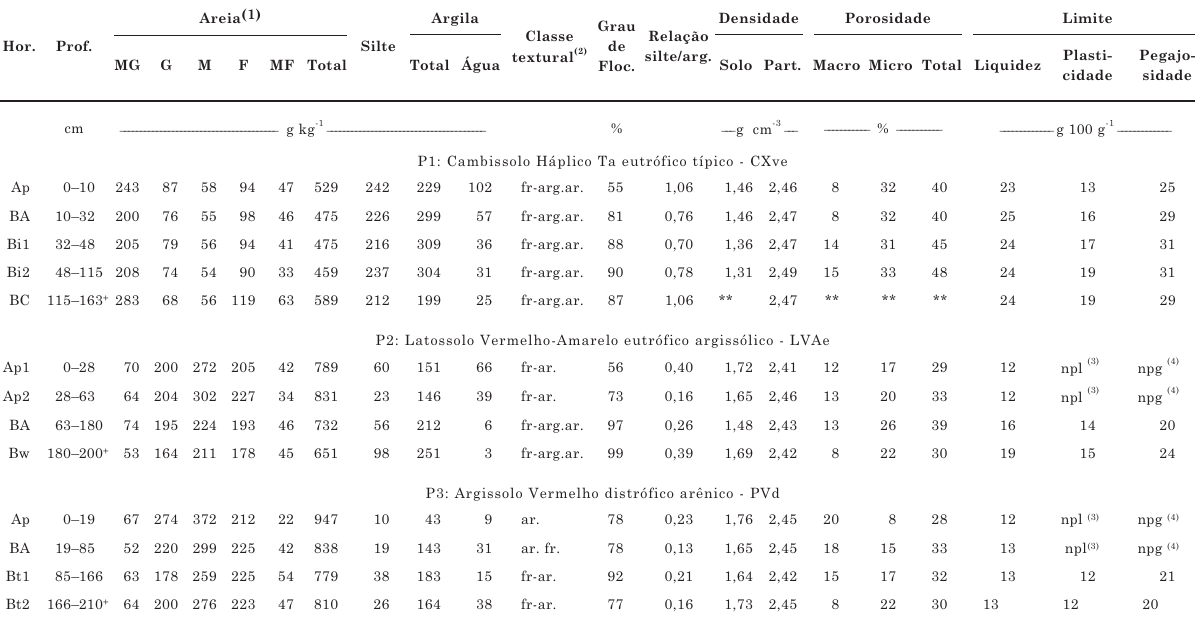
P3: Argissolo Vermelho distrófico arênico -